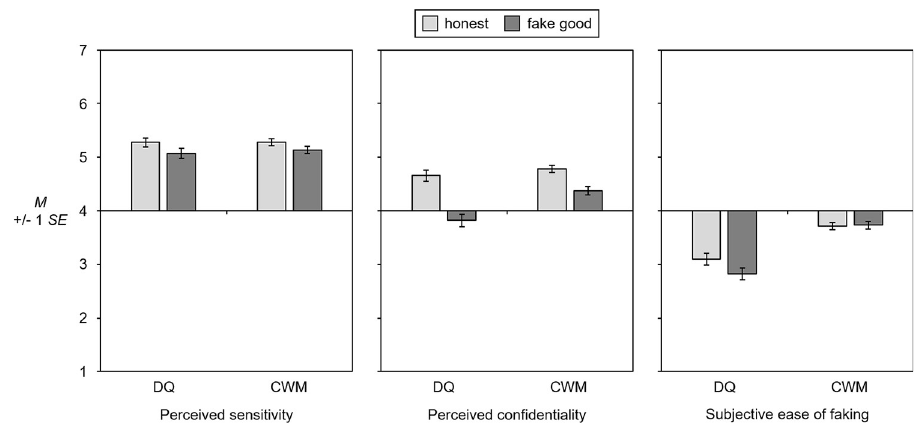
Fig 2. Mean plots for perceived sensitivity (higher values = higher sensitivity), perceived confidentiality (higher values = higher confidentiality), and subjective ease of faking (higher values = harder to fake). DQ = direct questioning, CWM = crosswise